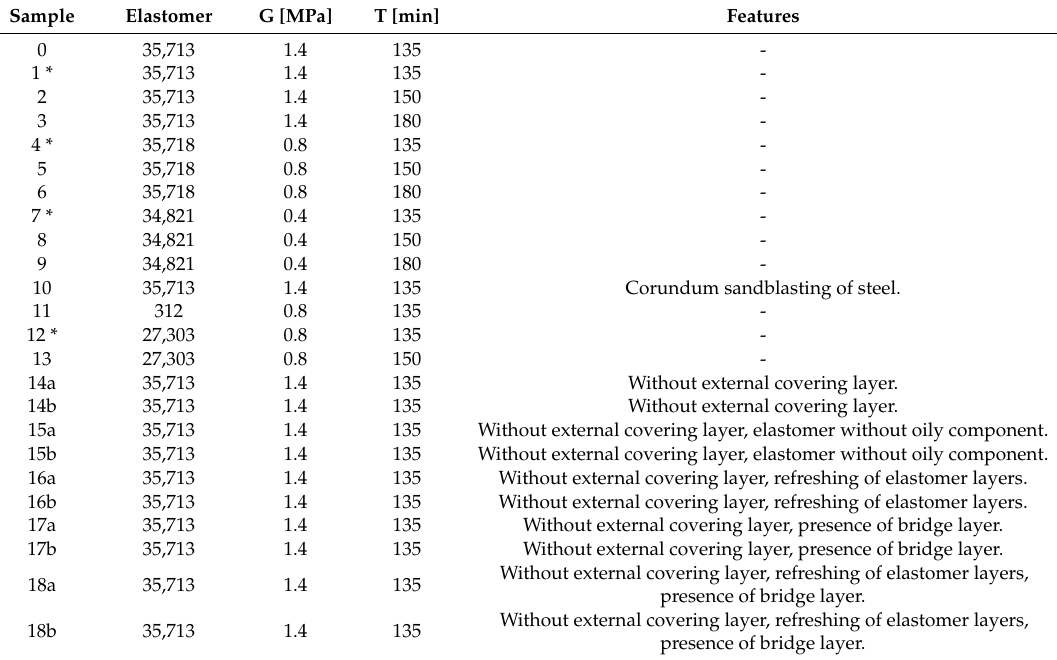
Table 1. Characteristics of the samples subjected to uniaxial tensile